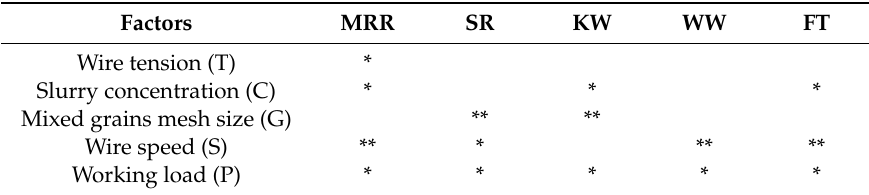
Table 5. E ff ect of control factors on